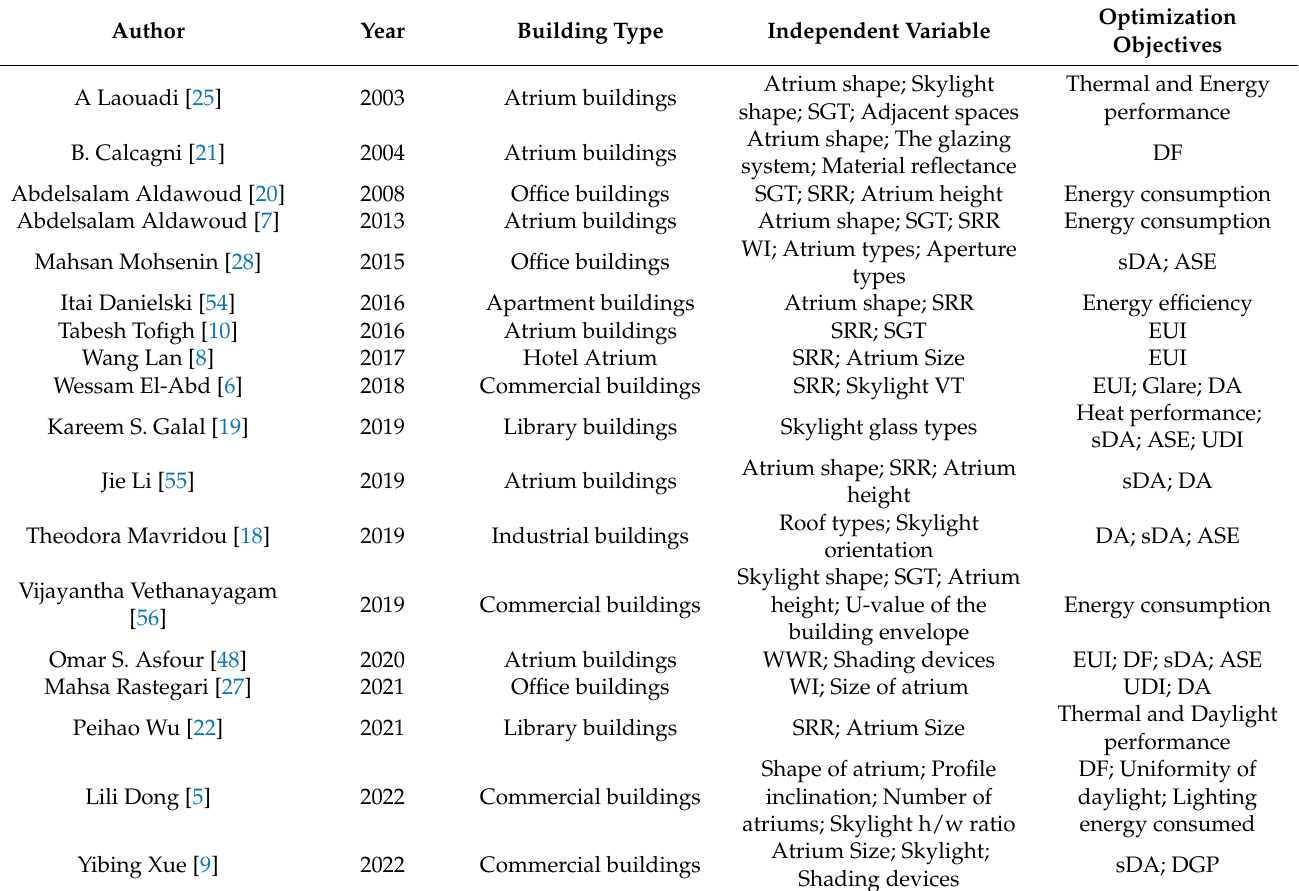
Table 1. Atrium Research